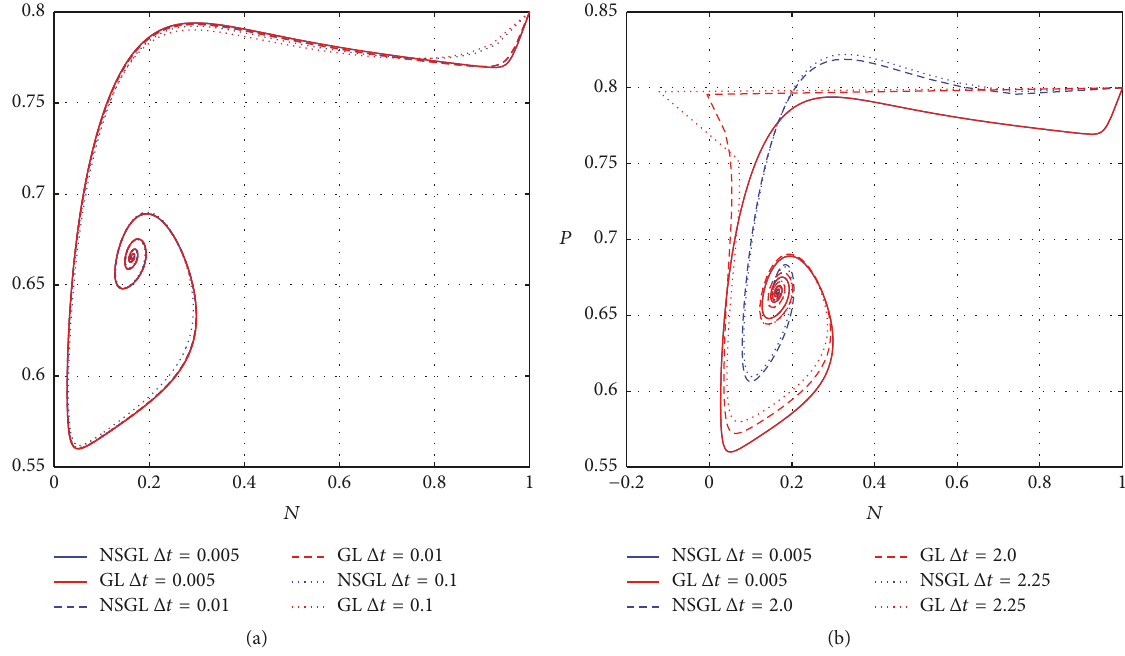
Figure 5: Phase portrait of system (6) calculated using nonstandard (NSGL) and standard (GL) schemes. The values of parameters are 𝑠 = 0.02 , 𝑘 = 0.5 , 𝑚 = 0.2 , ℎ = 0.3 , 𝜔 = 0.7 , 𝑎 = 1 , 𝑏 = 0.5 , 𝑐 = 0.1 , and 𝛼 = 0.95 .